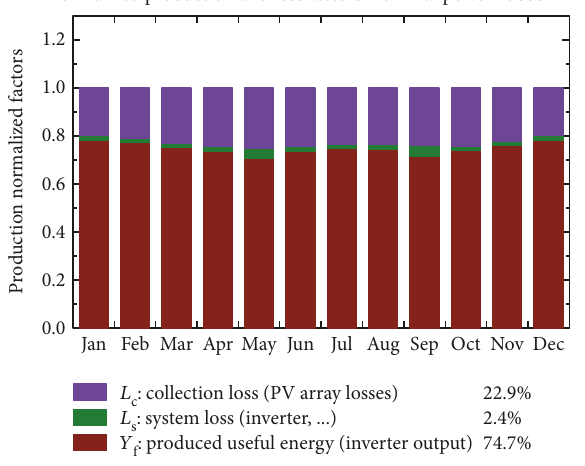
Figure 6: Monthly graph of normalized production and loss factor.